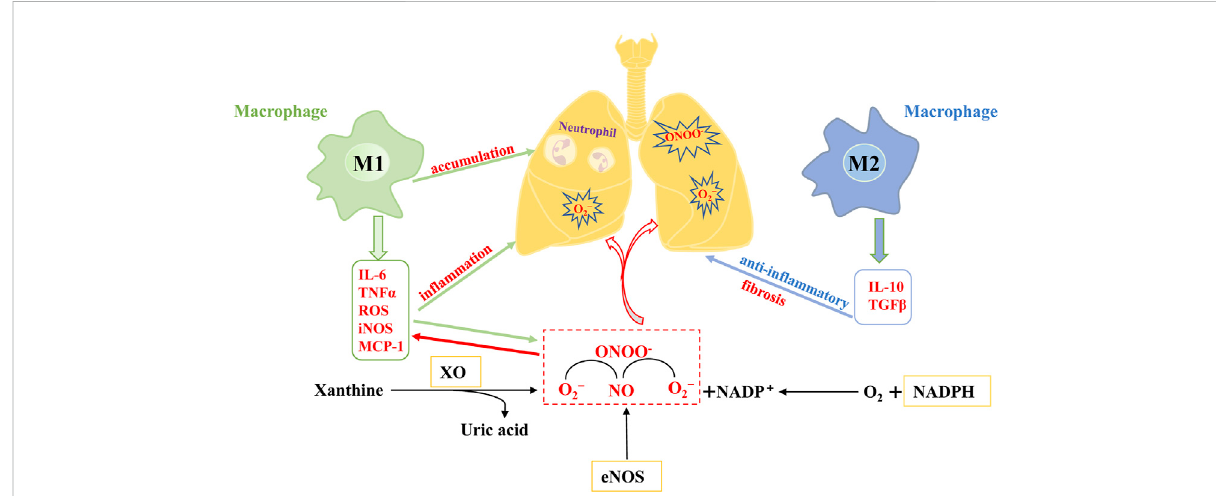
Mechanism of excessive in fl ammation and oxidative stress in ALI/ARDS. When lung endothelial cells are damaged, NADPH oxidase promotes the production of the superoxide anion (O 2 − ), and xanthine oxidase (XO) catalyzes the oxidation of purine substrates to produce uric acid and O 2 − . In addition, NO derived from endothelial nitric oxide synthase (eNOS) forms highly reactive peroxynitrite with O 2 − (ONOO-), exacerbating nitri fi cation and oxidative damage in the lungs. Under the stimulation of various in fl ammatory and oxidative factors, macrophages polarize into M1 and M2 types. M1 macrophages secrete pro-in fl ammatory factors such as IL-6, MCP-1, and TNF α and aggravate neutrophil in fi ltration, leading to severe acute in fl ammatoryinjury of thelung. M2macrophages secreteIL-10, TGF β , and otherfactorsconducive to in fl ammatory control, but theexcessive production of these factors will aggravate the process of pulmonary fi brosis. In conclusion, the vicious cycle formed by excessive in fl ammation and oxidative stress intensi fi es the pathogenesis of